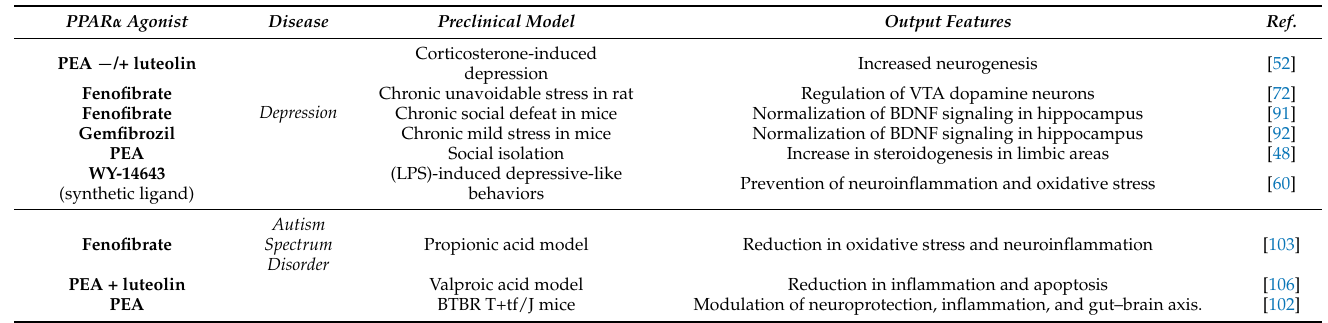
Table 1. Overview of preclinical animal models and primary findings of studies providing evidence for a role of PPAR α in neuropsychiatric and neurodegenerative